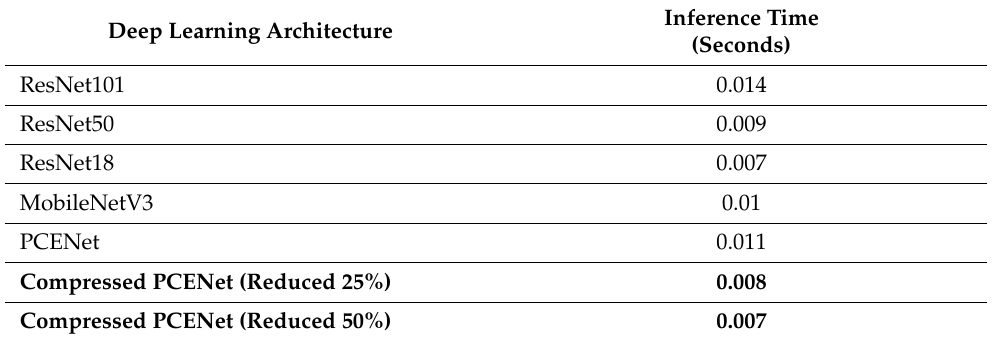
Table 4. Inference time assessment on the server.